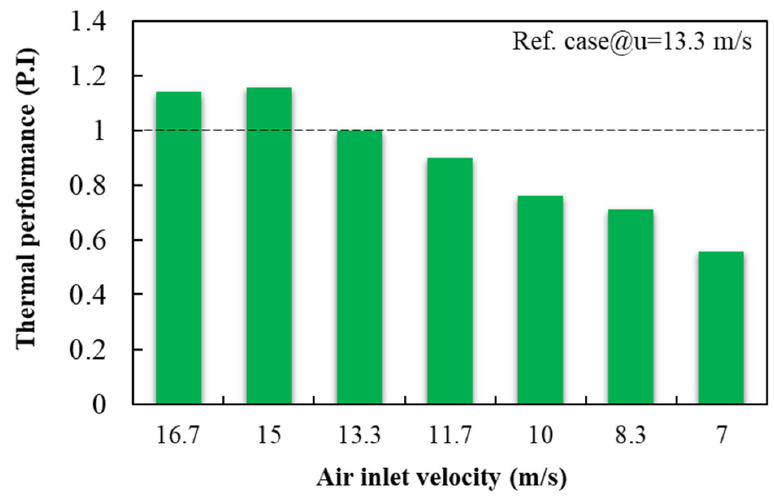
Figure 12. Effect of air inlet velocity on the calculated thermal performance index (PI).